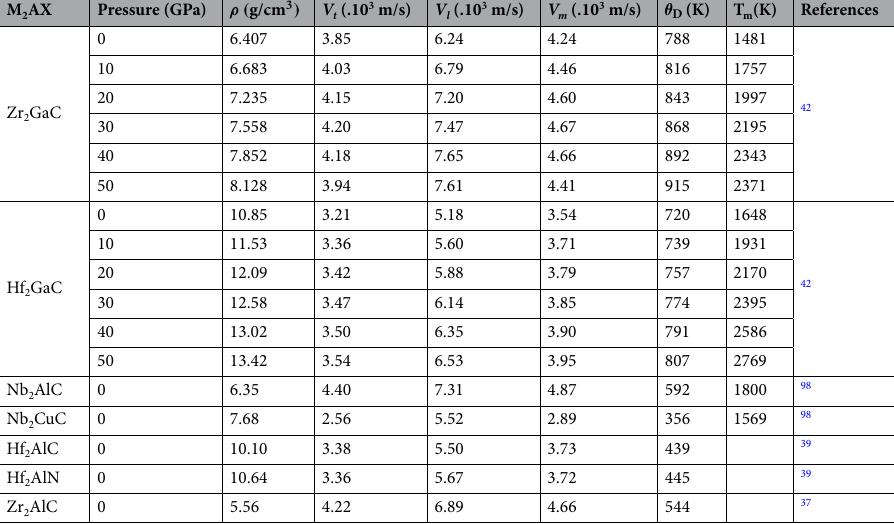
elastic anisotropy of Hf 2 GaC is more significant than that of the Zr 2 GaC MAX phase. According to the deviation degree of spherical shape, the anisotropy of Hf 2 GaC is bigger than Zr 2 GaC (See Fig. 11b). Optical properties. The optical properties for the M 2 GaC MAX phase (M = Zr, Hf) were determined for